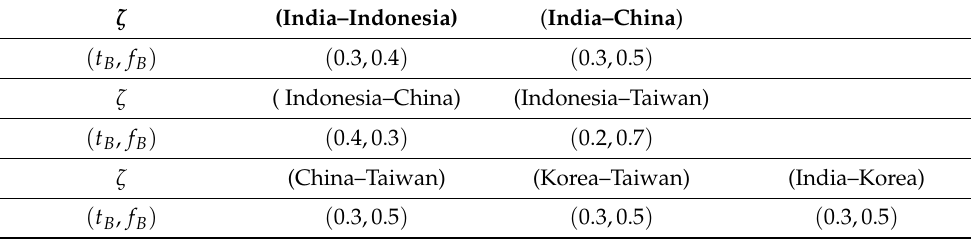
Table 5. Weight of edges in VG ζ